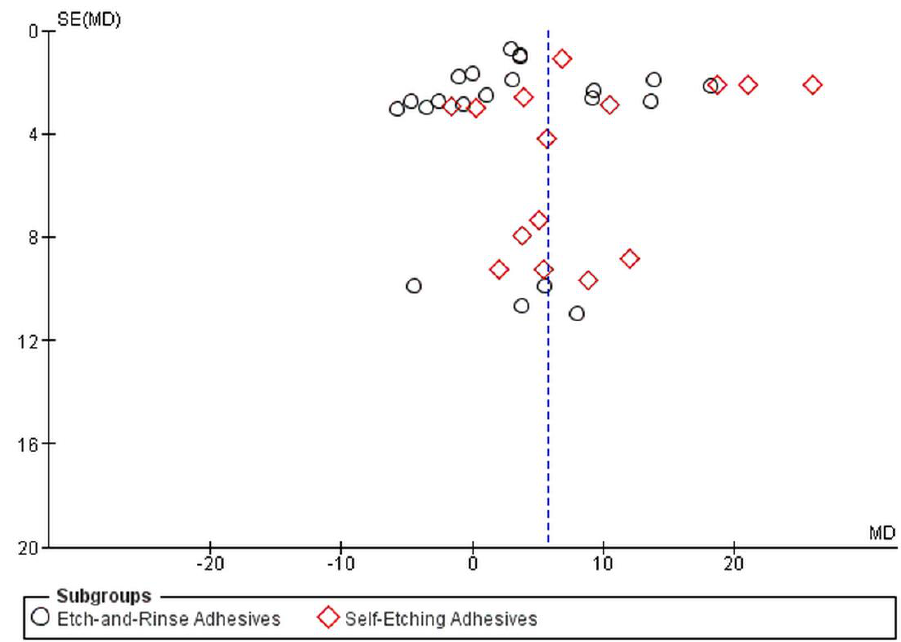
Figure 2. Funnel plot of the included studies.